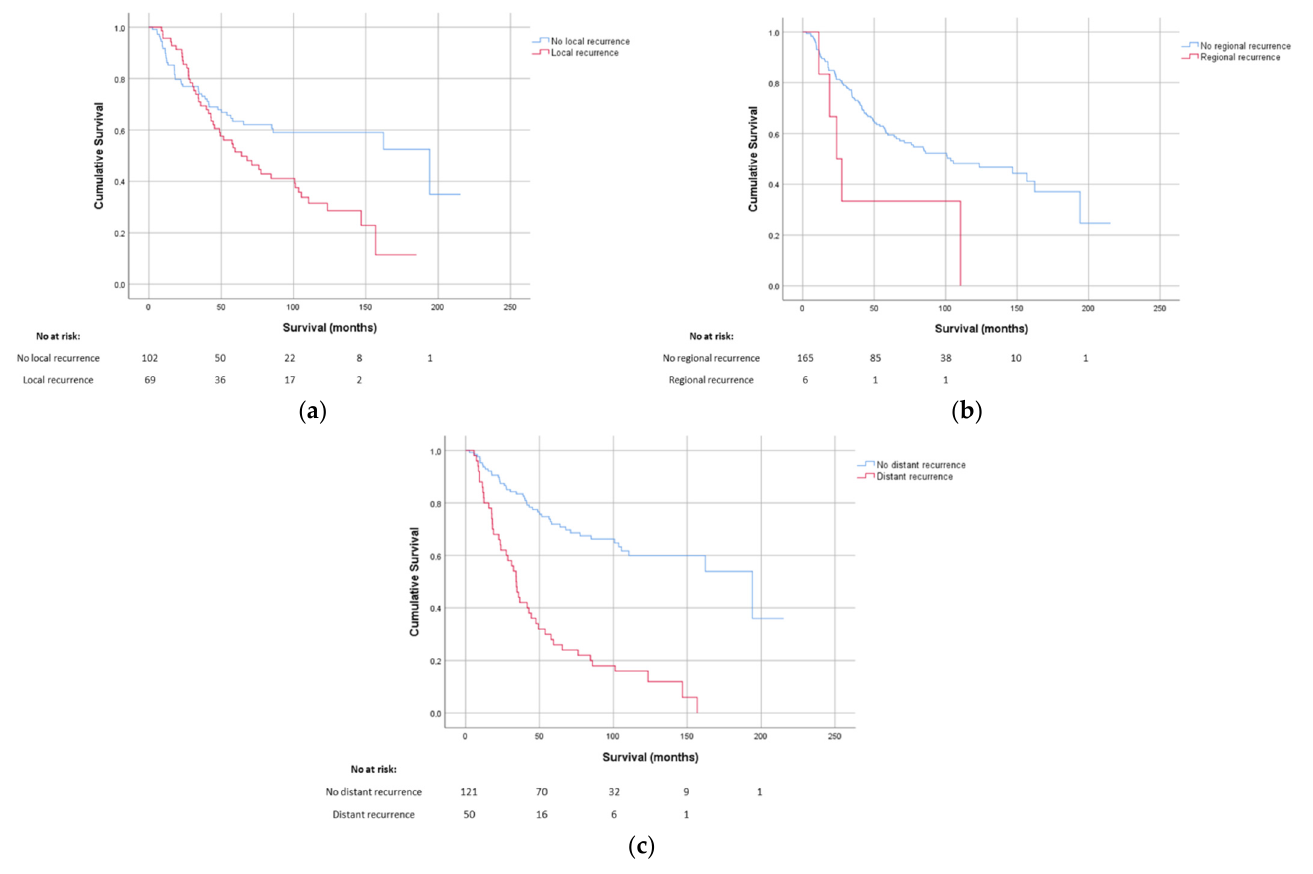
Figure 2. Overall survival of MFS patients with recurrence/metastasis as calculated from date of first diagnosis. ( a ) Kaplan–Meier curves showing the difference in survival with and without local recurrences, ( b ) Kaplan–Meier curves showing the difference in survival with and without regional recurrences, ( c ) Kaplan–Meier curves showing the difference in survival with and without distant recurrences .